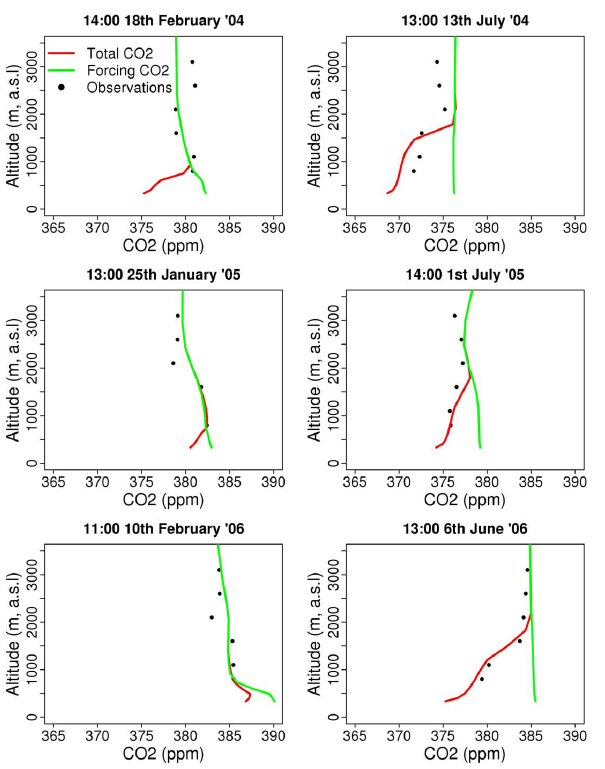
Fig. 4. Observed and WRF-SPA modelled profiles of CO 2 above Griffin Forest. Modelled profiles include the total atmosphere pro- file CO 2 and “forcings only” CO 2 to show the impact of the mod- elled